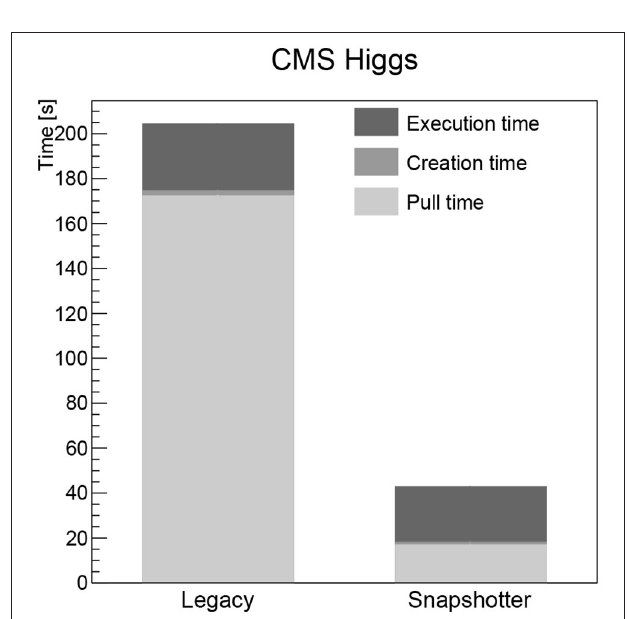
FIGURE 3 | Summary of the overall run time of the CMS Higgs boson analysis workload analyzed split into the container image pull time, the time to start the job after the container is ready as well as the time for the actual workload comparing the legacy and the snapshotter approaches.